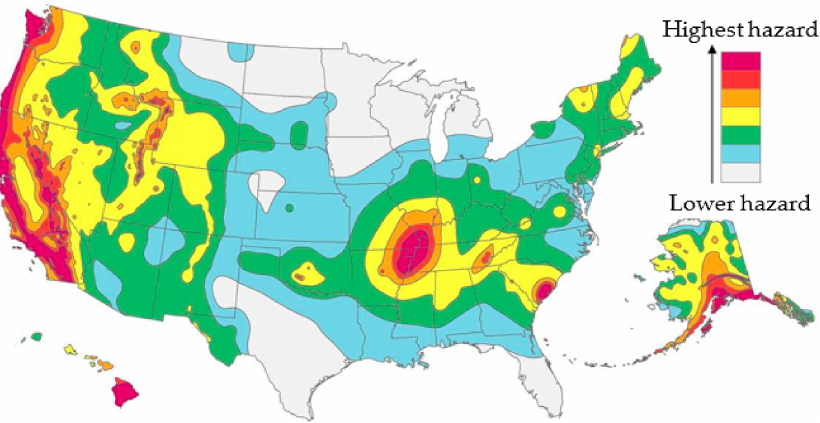
Figure 15. Seismic hazard map for the USA according to the USGS